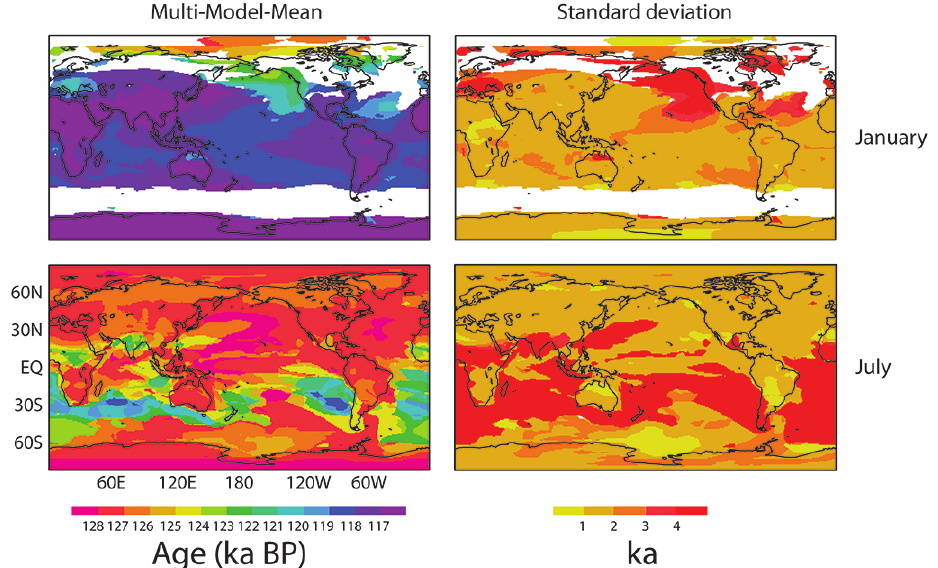
Fig. 5. MMM (left) and STDEV (right) of the timing of maximum warmth (MWT) for January and July based on the individual simulations as shown in Fig. 4. The standard deviation gives a measure of the spread in the simulated timing of maximum warmth between the different models (ka; 2 σ ). The MMM and STDEV are only shown if in at least four individual simulations we find a maximum temperature along a fitted polynomial which is outside the 1 σ range of the model individual LIG mean (see Fig. 4). Note that the calculations do not include the Bern3D model north of 76 ◦ N and south of 76 ◦ S in accordance with its latitudinal grid limits. The calculations do include the KCM and MPI-UW simulations. However, since they only run from 126–115kaBP and 128–115kaBP respectively, this might slightly offset the results shown in this